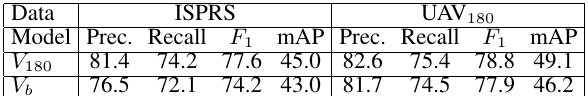
Figure 3. Qualitative results of V 360 on UAV 360 test images. White arrows point to the predictions of vehicle headings.